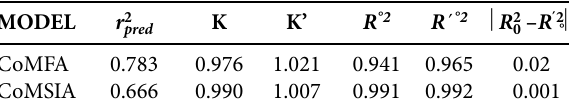
Table 3. Predictive power results for the external test set; Golbraikh and Tropsha criteria MODEL